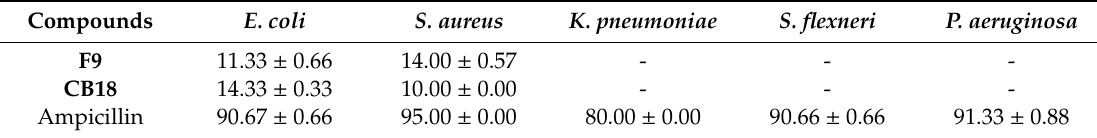
Table 2. Antibacterial activities (% inhibition) of isolates from P. cretica and standard ampicillin at 1 mg / mL. Each value is average of three repeated experiments ± standard error (S.E.). Compounds E. coli